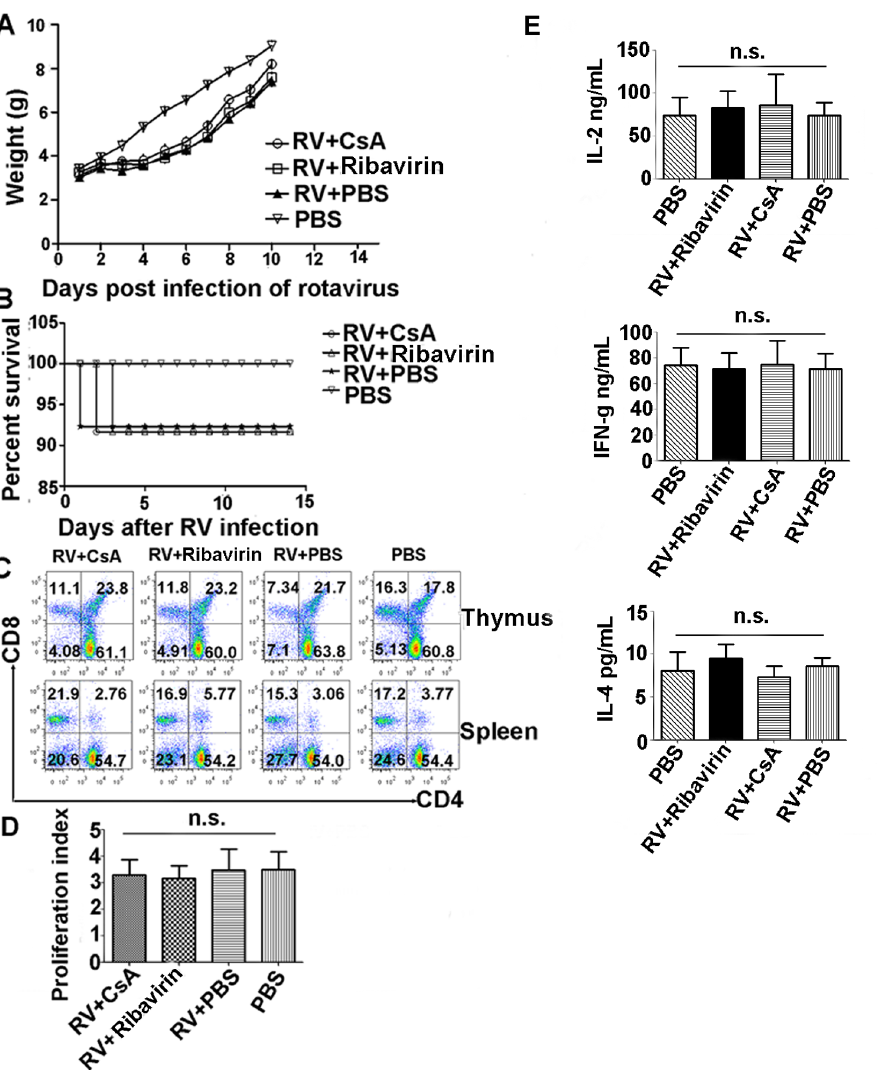
Figure 7. CsA toxicity analysis in the animal model. Body weight growth curve (A) and survival curve (B) after CsA treatment of RV-infected BALB/c mice. Body weight or survival were monitored among the 4 groups of mice during the week following rotavirus infection challenge CsA or PBS treatment (mean 6 SEM, n . 10). (C) CD4/CD8 T-cell ratio analysis in spleens and thymus from RV-infected mice treated with CsA or Ribavirin. (D) Proliferation assay of splenocytes in RV infected and CsA treatment mice by CFSE labeling. Ribavirin treatment mice as positive control and PBS treatment mice as negative control. Proliferation index (PI) was 3.47 6 0.37, 3.16 6 0.47, 3.47 6 0.79, 3.49 6 0.67 respectively. (E) IL-2, IL-4, and IFN- c analysis from cell culture supernatants by sandwich ELISA. Data are representative of at least 3 independent experiments (n=10 mice/group). Error bars indicate the SD with technical triplicates. N.s., not significant (* P , 0.05, ** P , 0.01).